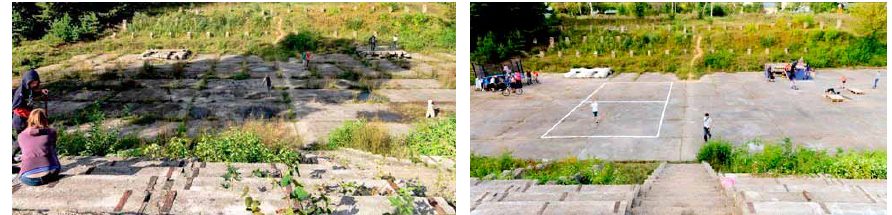
Fig. 1. Stadium space in Viečiūnai before (left) and after (right) creative workshops. Result: the paving renewed and cleaned from grass, making it suitable for skateboarders and skaters. The space is equipped with urban furniture and ramps. Photo by Aurelija Slapikaitė-Jurkonė